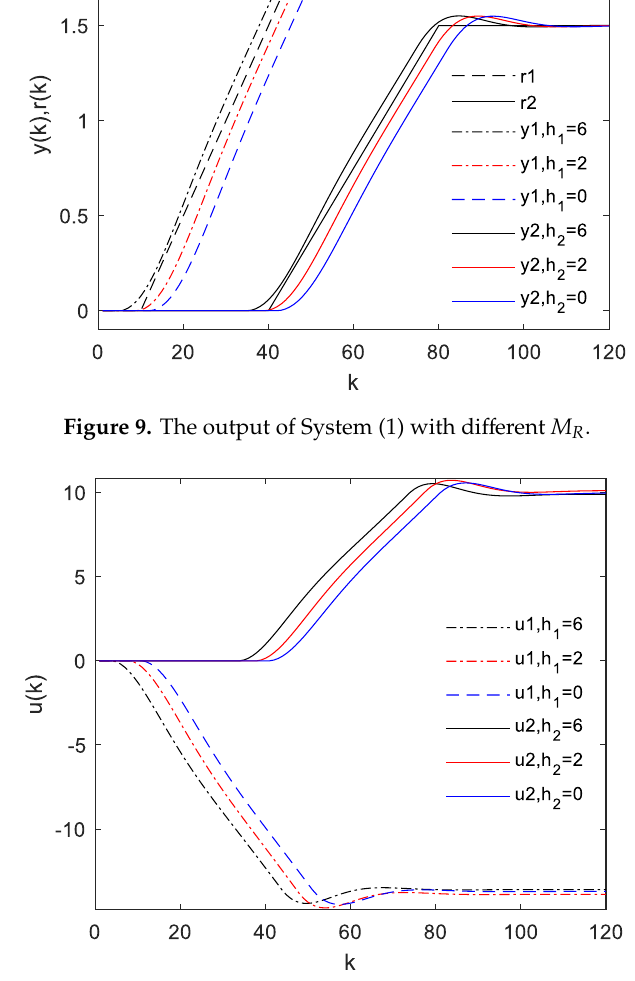
Figure 10. The control input of System (1) with different R M .